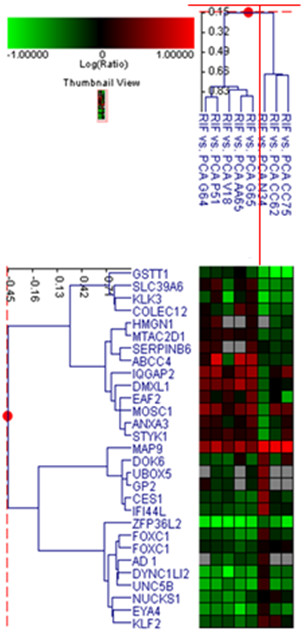
Cluster analysis applied to 8 EGFR-mutated samples using the 29-gene signature distinguished two classes. On the left branch, EGFRlow samples and on the right branch EGFRhigh samples.